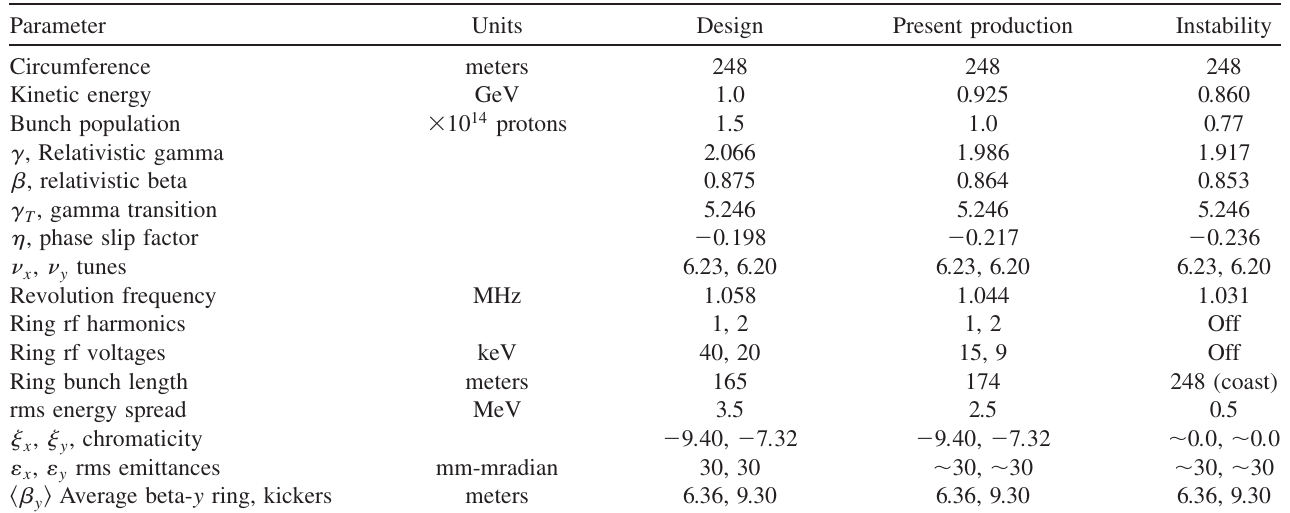
TABLE I. SNS ring parameters.